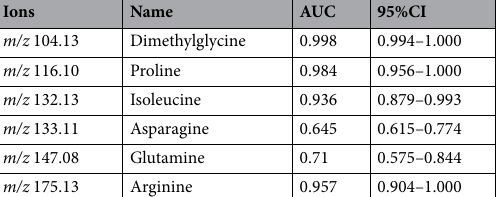
Table 2. The AUC and 95% CI of amino acids by ROC curve analysis. AUC, area under the receiver operating characteristic (ROC) curve; 95% CI, 95% confidence